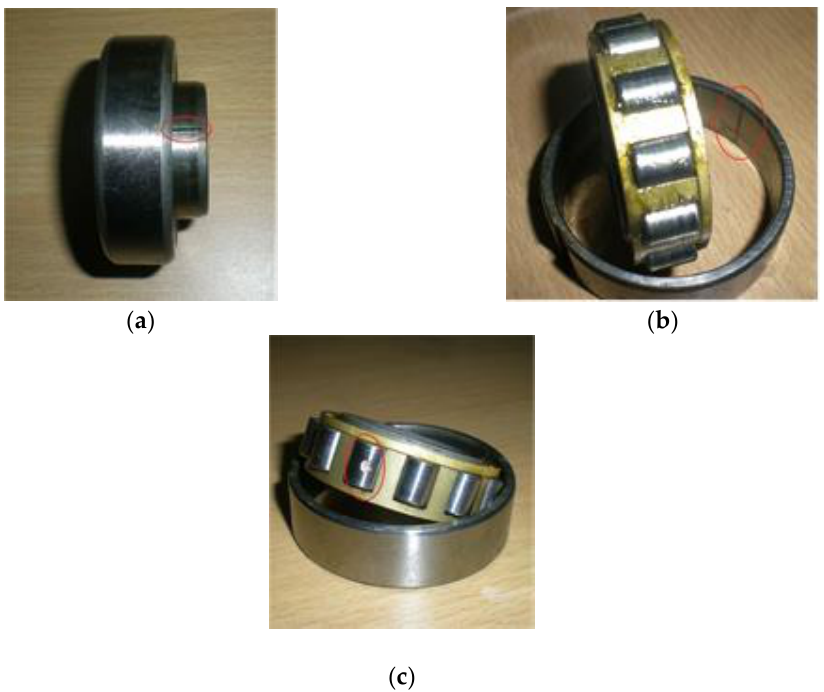
Figure 14. Three fault conditions of the faulty bearings: ( a ) Inner-race fault; ( b ) outer-race fault; ( c ) rolling element fault.